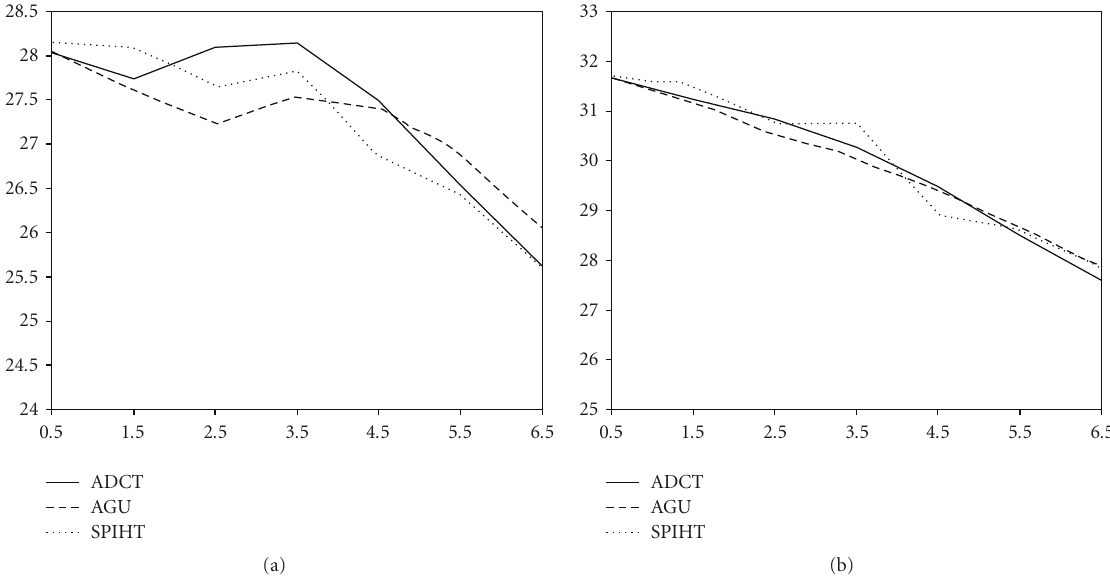
Figure 10: Dependencies of PSNR-HVS-M (a) and WSNR (b) on b for di ff erent coders, σ 2 = 200, image